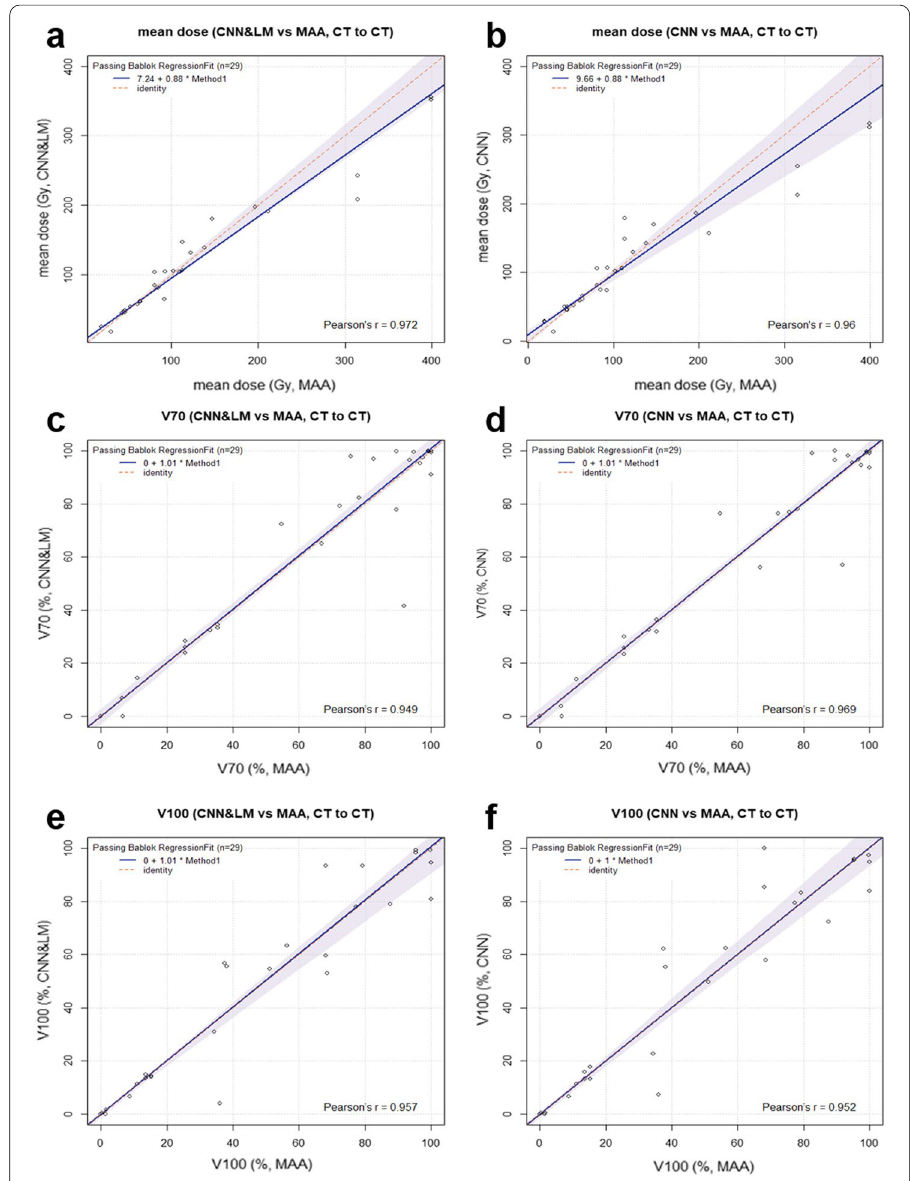
Fig. 10 Passing-Bablok plots for the mean dose, V70, and V100 estimated on the floating CT lesions registered by the CNN&LM- or CNN-guided algorithm versus the mean dose, V70, and V100 estimated on the reference lesions. MAA: the reference lesions. CNN&LM: the floating lesions registered by the CNN&LM-guided registration. CNN: the floating lesions registered by the CNN-guided